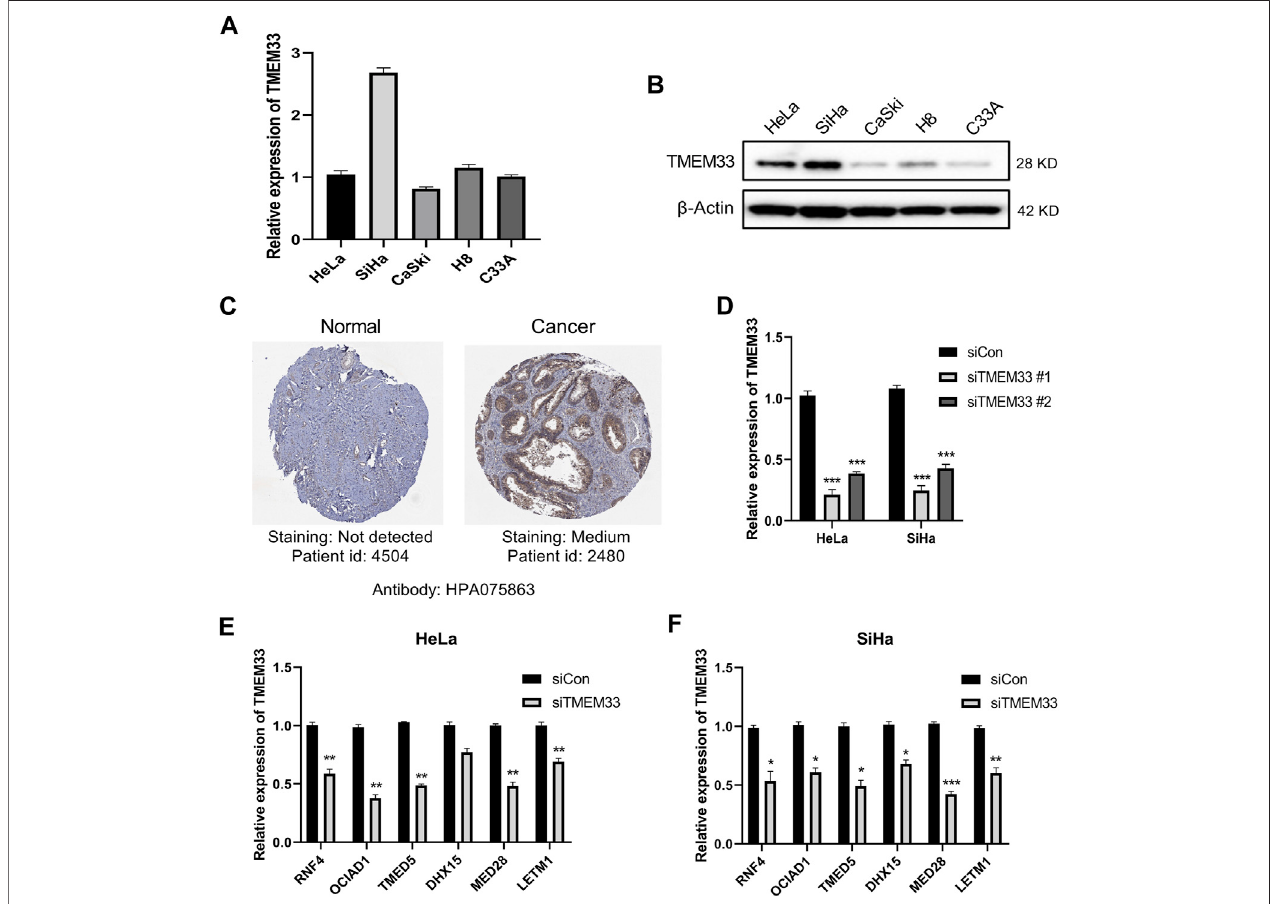
FIGURE 6 | TMEM33 correlates with tumorigenesis-related genes in cervical cancer cells. (A) RT-qPCR analysis of relative mRNA level of TMEM33 in cervical cancer cell lines (HeLa, SiHa, CaSki, H8 and C33A). (B) Immunoblotting analysis of TMEM33 expression in cervical cancer cell lines. (C) Representative immunohistochemistry images of TMEM33 in CESC and normal cervix tissues derived from HPA database. (D) siTMEM33 (20 nM) and siCon (20 nM) were transfected withLipofectamine2000accordingtothemanufacturer ’ sprotocol.At48 hpost-transfection,theef fi ciencywasdetermined byRT-qPCR. (E,F) RT-qPCRanalysis of relative mRNA level of RNF4, OCIAD1, TMED5, DHX15, MED28 and LETM1 in HeLa and SiHa cells transfected with TMEM33 siRNA. Data are mean ± SD of three independent experiments, * p < 0.05, ** p < 0.01, and *** p < 0.001.